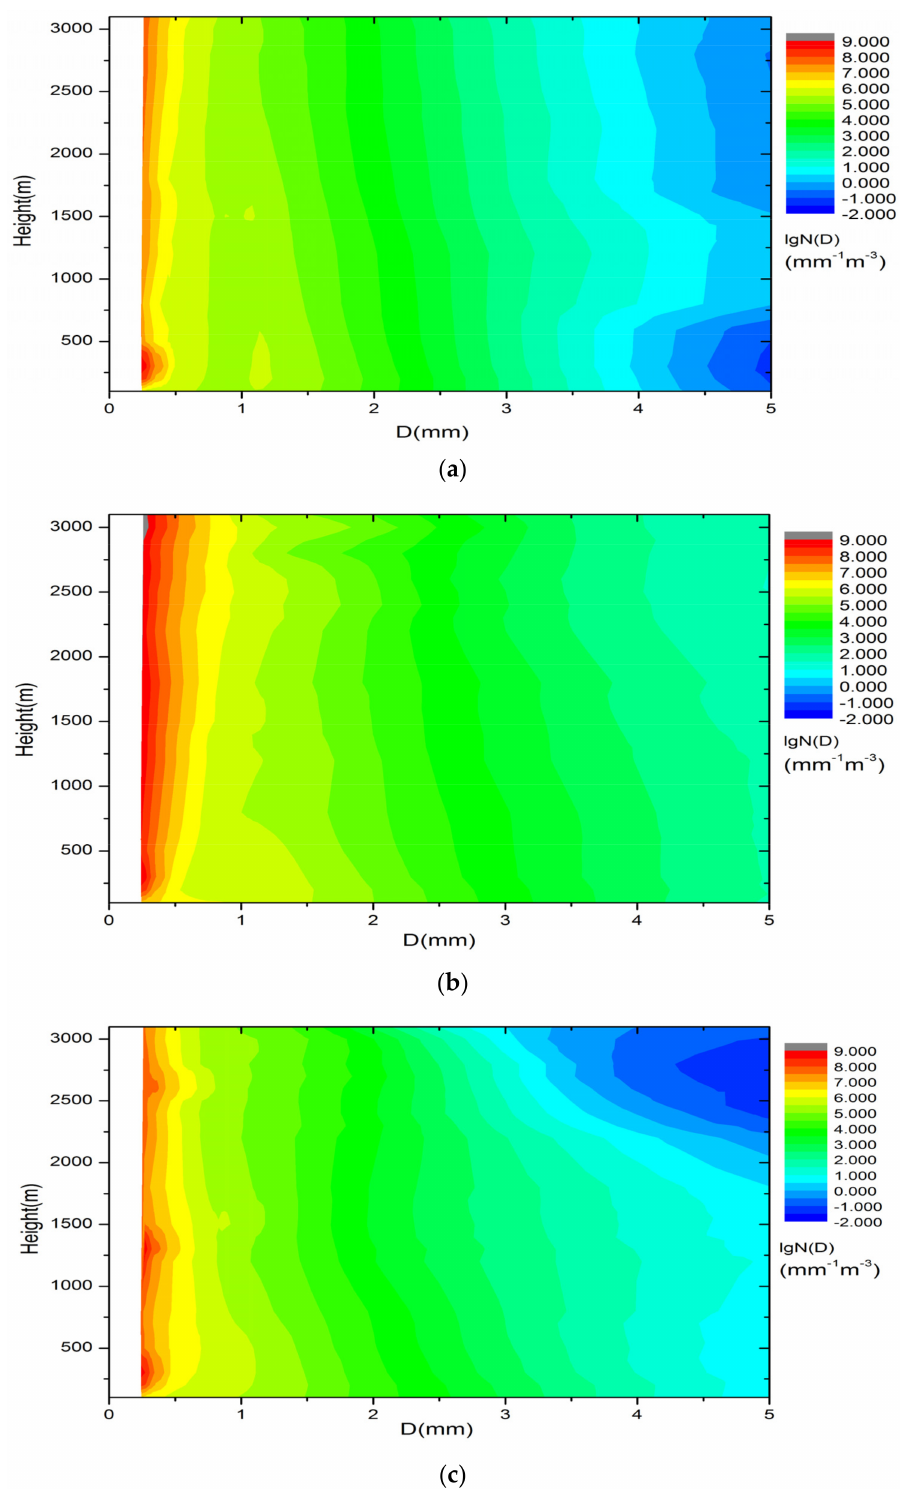
Figure 8. Vertical distribution of average DSDs detected by the MRR ( a ) 1640–1800 LST on 22 June (the left margin in the figure is the missing observation data, which also appears in the other DSDs figure); ( b ) 0300–0400 LST on 28 June; ( c ) 1510–1620 LST on 11